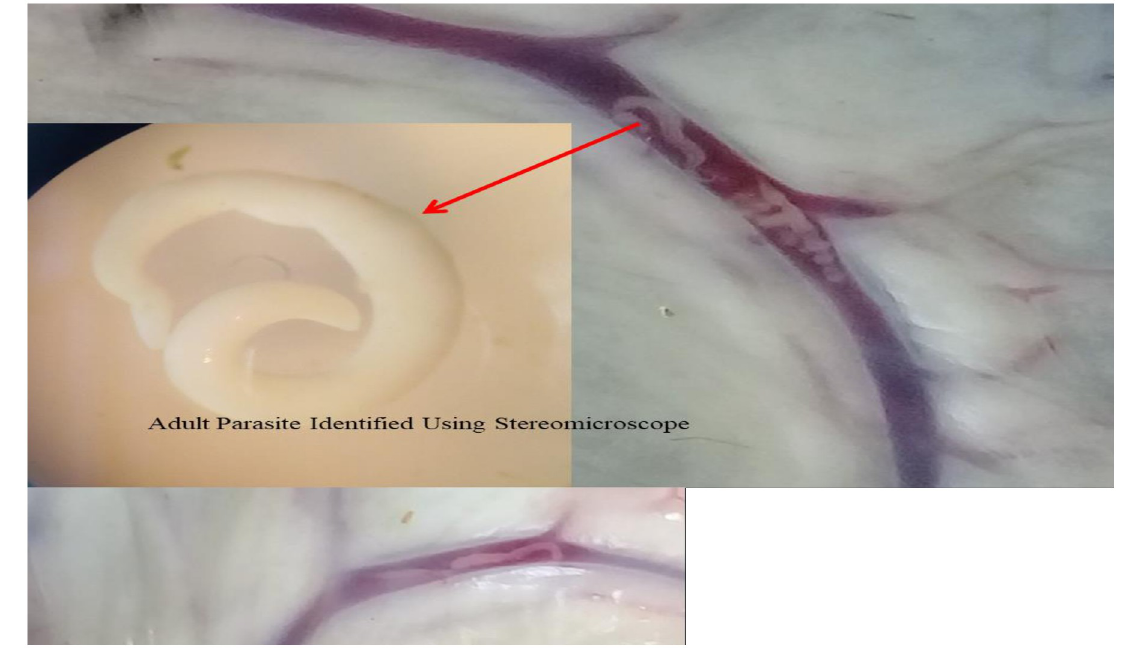
Fig 2. Adult S.bovis in the mesenteric vein of cattle and it’s morphological